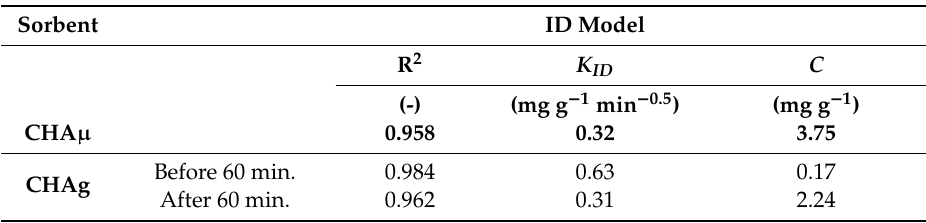
Table 3. ID parameters for CHA µ and CHAg; CHAg has two distinct patterns, before and after 60 min of contact with CSM.